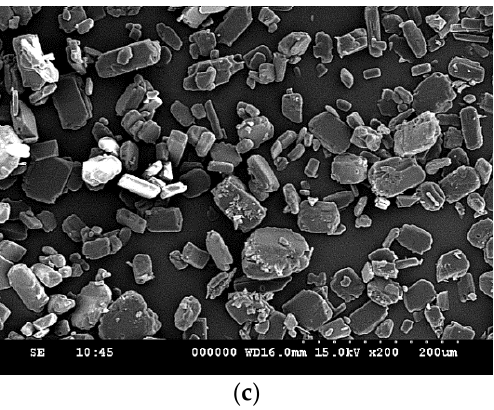
Figure 4. SEM images of salicylamide: ( a ) original crystals; ( b ) crystals obtained in Experiment B1; and ( c ) crystals obtained in Experiment 5.